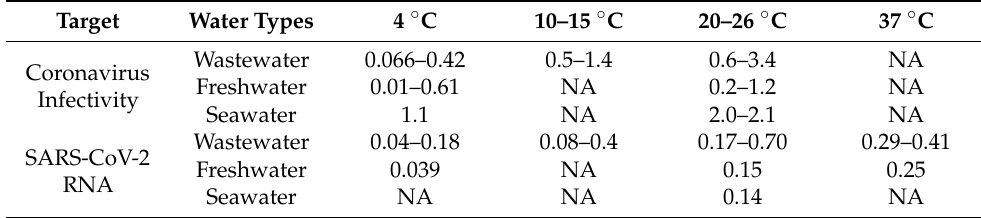
Table 2. Summary of decay rate constants (d − 1 ).